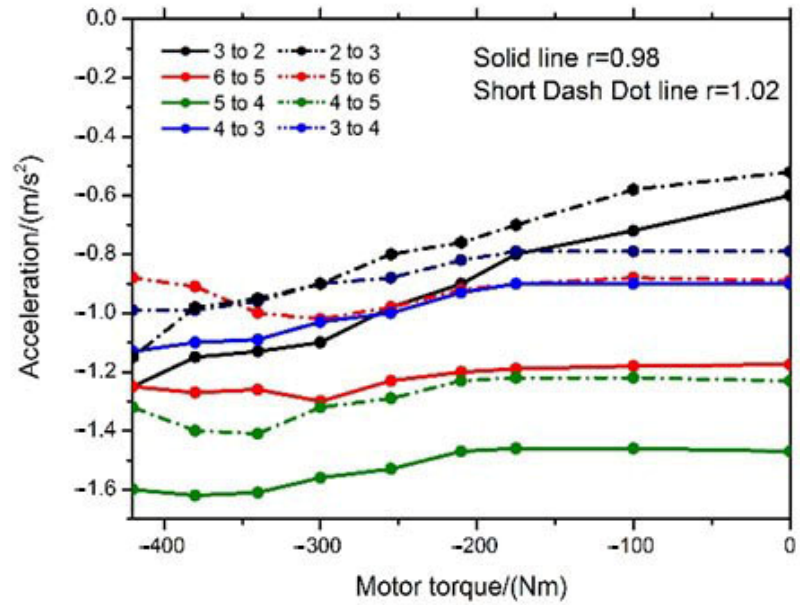
Figure 11. Gear shifting area division.